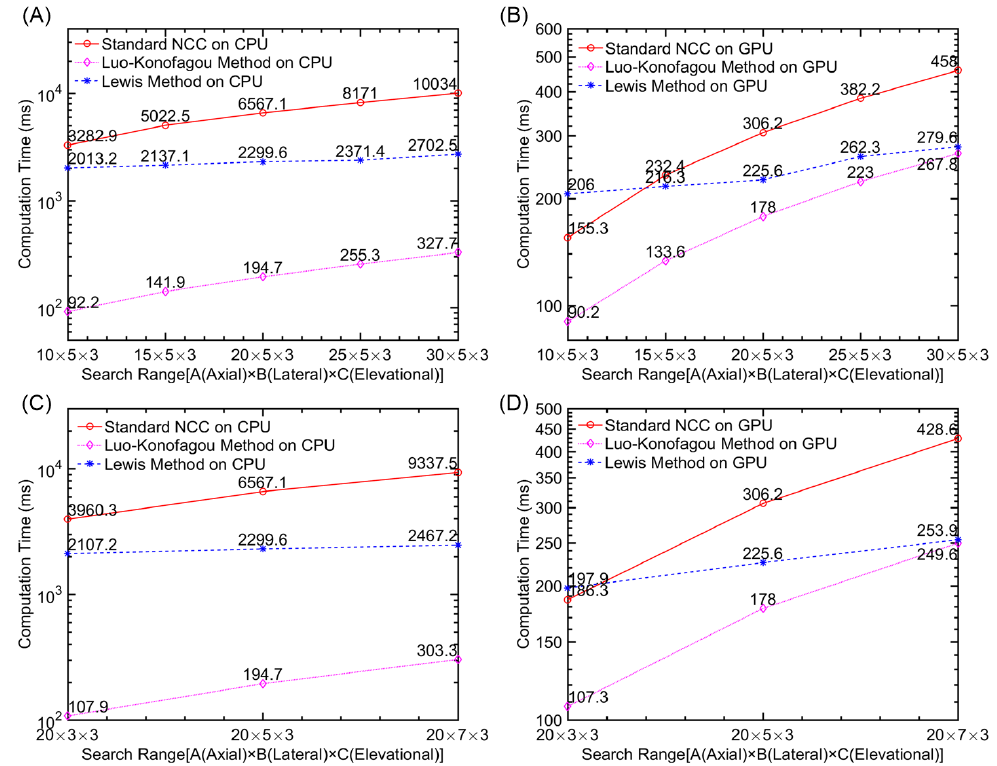
Figure 7. Plot showing computing time when the search range changed under the ( A , C ) CPU and ( B , D ) GPU environments. In all plots, the computing time is displayed in log 10 scale. Computing time was estimated based on the completion of 3-D motion tracking for a single slice of ultrasound